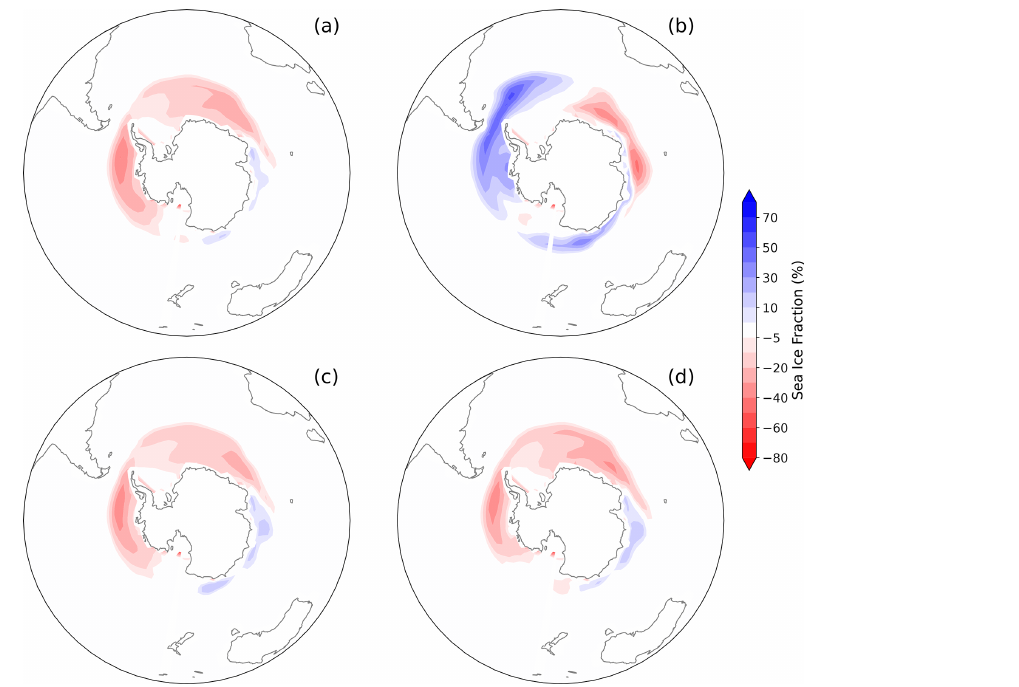
Figure B4. Sea ice fraction difference (%) between future scenario (2041–2070) (a) RCP8.5, (b) WAIS3m, (c) GrIS1m, (d) GrIS3m and historical simulation (1976–2005) for the Southern Hemisphere in